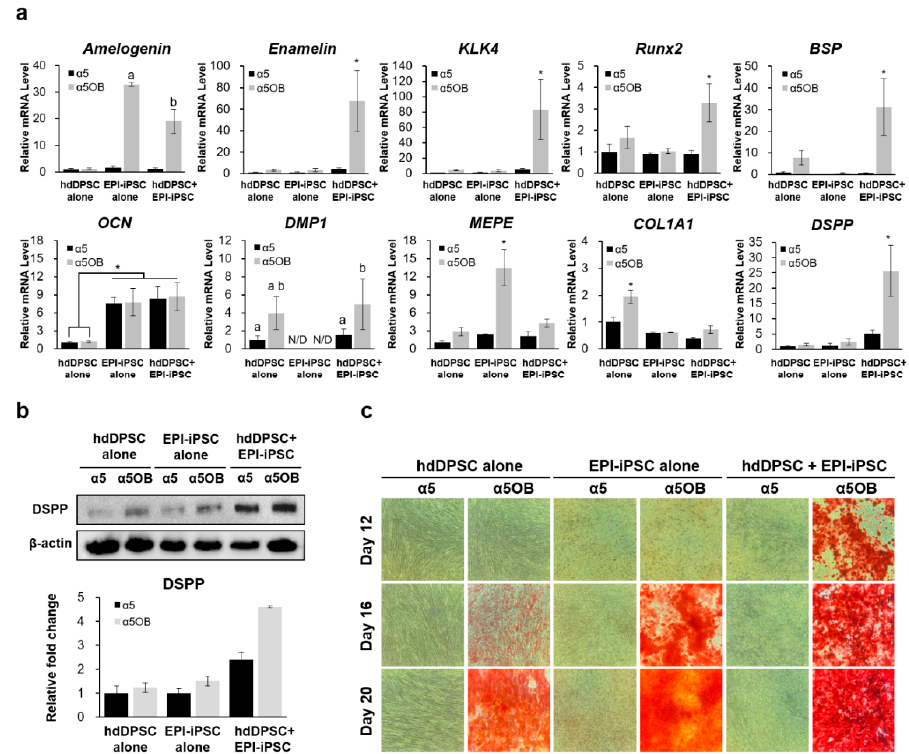
Figure6. E ff ectoftheEPI-iPSCcelllineontheodontogenicdi ff erentiationandmineralizationofhdDPSC. Figure 6. Effect of the EPI-iPSC cell line on the odontogenic differentiation and mineralization of EPI-iPSC and hdDPSC were co-cultured with or without a di ff erentiation medium. The hdDPSC. EPI-iPSC and hdDPSC were co-cultured with or without a differentiation medium. The hdDPSC and EPI-iPSC alone group was analyzed as a control group. ( a ) Expression of ameloblast markers ( Amelogenin , Enamelin , and KLK4 ) and odontoblast markers ( Runx2 , BSP, OCN, DMP1 , MEPE , Col1A1 , and DSPP ) was analyzed by real-time PCR after eight days in culture. ( b ) Expression patterns of dentin sialoprotein (DSPP) were evaluated by a western blot after 12 days in culture. ( c ) Mineralized nodule formation of co-culture with EPI-iPSC and hdDPSC in vitro was evaluated by Alizarin red S staining on days 12, 16, and 20. Data are presented as the mean ± SD, n > 3 per group. a,b, * p < 0.05. N/D: Not detected. Additionally, these expression patterns were further confirmed by a western blot. Consistent with gene expression, dentin sialoprotein (DSPP) proteins were highly expressed when co-culturing with hdDPSCs and EPI-iPSC compared with hdDPSC or EPI-iPSC alone (Figure 6b). Although DSPP was detected at day 12 in hdDPSC or EPI-iPSC alone under odontogenic induction, the expression was lower than in the co-culture group. The mineralized nodule formation was evaluated with Alizarin red S staining on day 12, 16, and 20 [26]. EPI-iPSC and hdDPSC were used as controls. The co-culture group in osteogenic medium exhibited highly increased nodule formation compared to controls at day 12. The size of mineralized nodules was markedly increased on day 20, while EPI-iPSC or hdDPSC alone showed fewer mineralized nodules (Figure 6c). 3. Discussion The epithelial–mesenchymal interaction plays an important role in the development of various organs, including mammalian teeth [27,28]. Many in vitro and in vivo studies in this area show that tooth formation is regulated by epithelial – mesenchymal interaction, during which ameloblasts are involved in the formation of enamel, while mesenchyme-derived odontoblasts form dentin [29]. Therefore, strategies involving epithelial – mesenchymal interaction have successfully regenerated tooth-like organoid structures [8,20,30]. However, clinical applications using such bioengineering